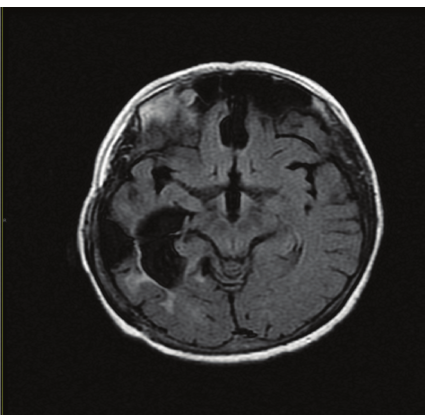
Figure 1: Axial FLAIR